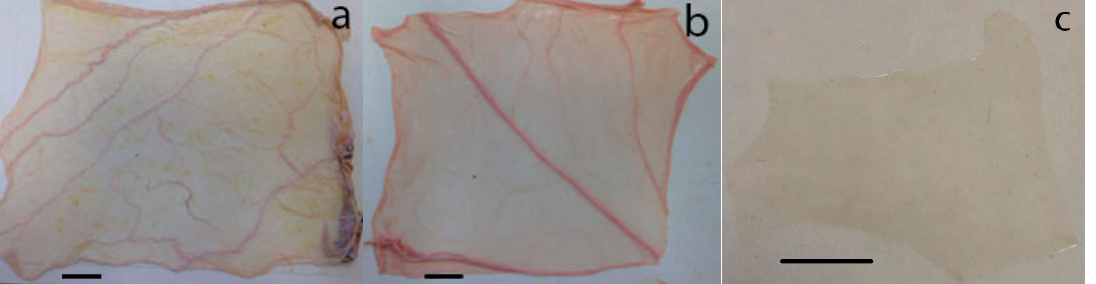
Figure 1. ( a ) Bovine chorioamniotic membrane, ( b ) equine chorioamniotic membrane, ( c ) bovine amnion (separated from the chorioamnion). Scale bar: 25 mm.